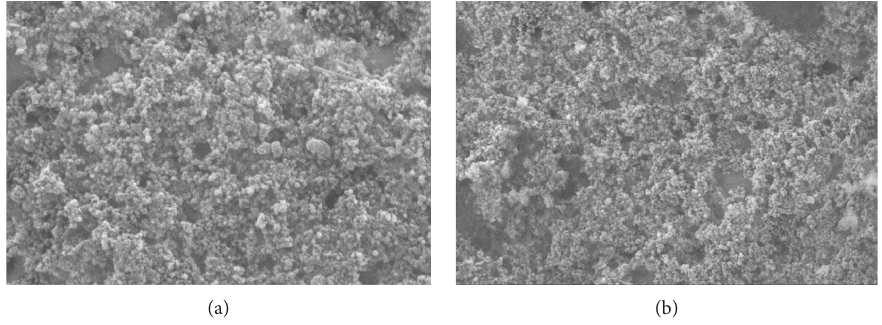
Figure 5: SEM images of stainless steel coating for (a) 200 ° C and (b) 500 ° C.